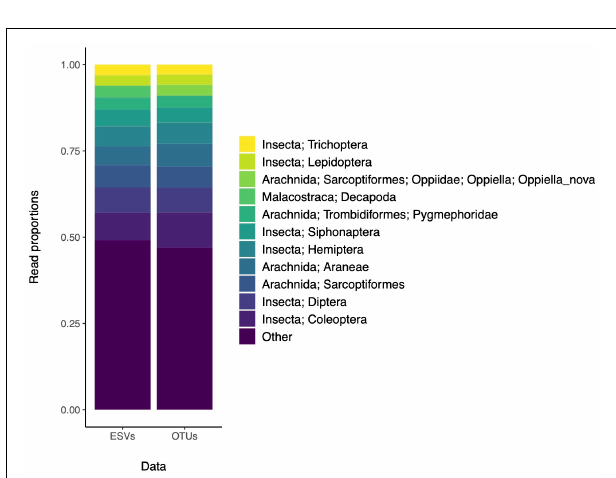
FIGURE 2 | The most abundant recovered taxa based on ESVs or OTUs are similar. Data is from a study that assessed arthropod diversity using COI metabarcoding of forest soil (Porter et al., 2019). The top 10 most abundant taxa are color coded according to the legend. Remaining clusters are binned into the “Other”